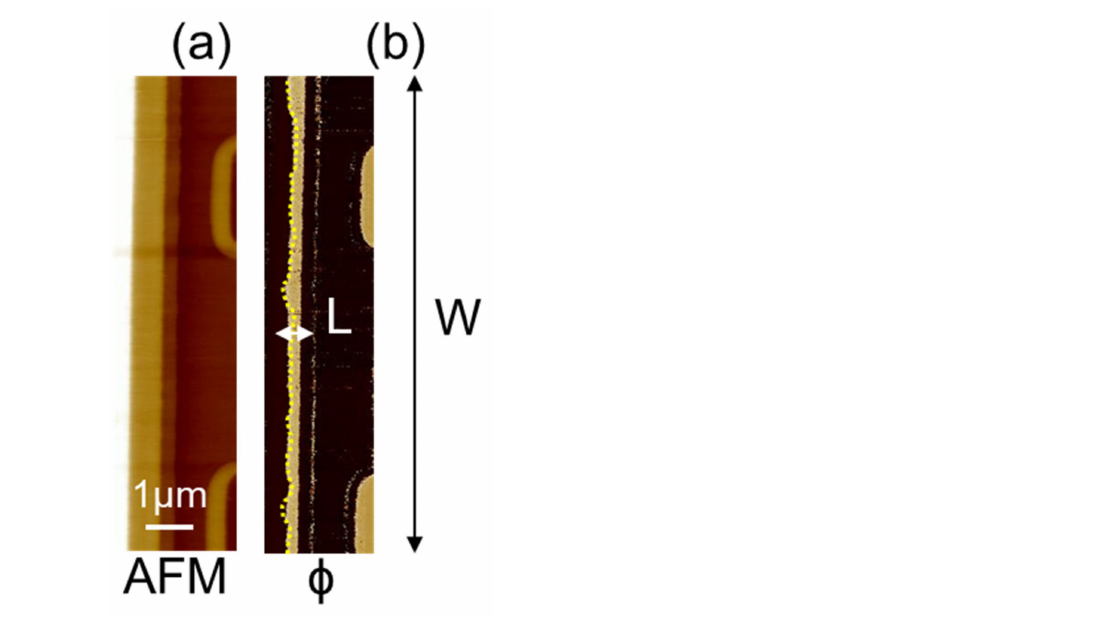
Figure 9. ( a ) AFM morphology and ( b ) SCM phase ( φ ) collected on a selected device that showed anomalous behavior compared with the desired